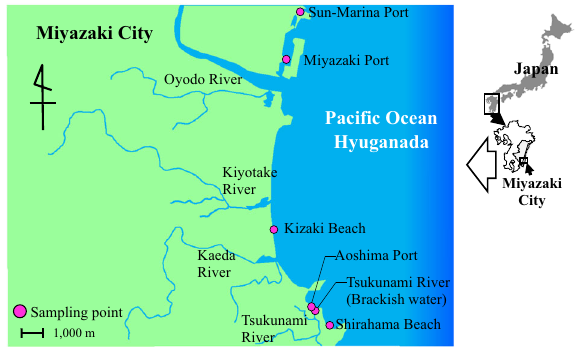
Fig. 8 Locations of sampling points at Aoshima Port, Tsukunami River, Kizaki Beach, Shirahama Beach, Miyazaki Port, and Sun-Marina Port in Miyazaki City,